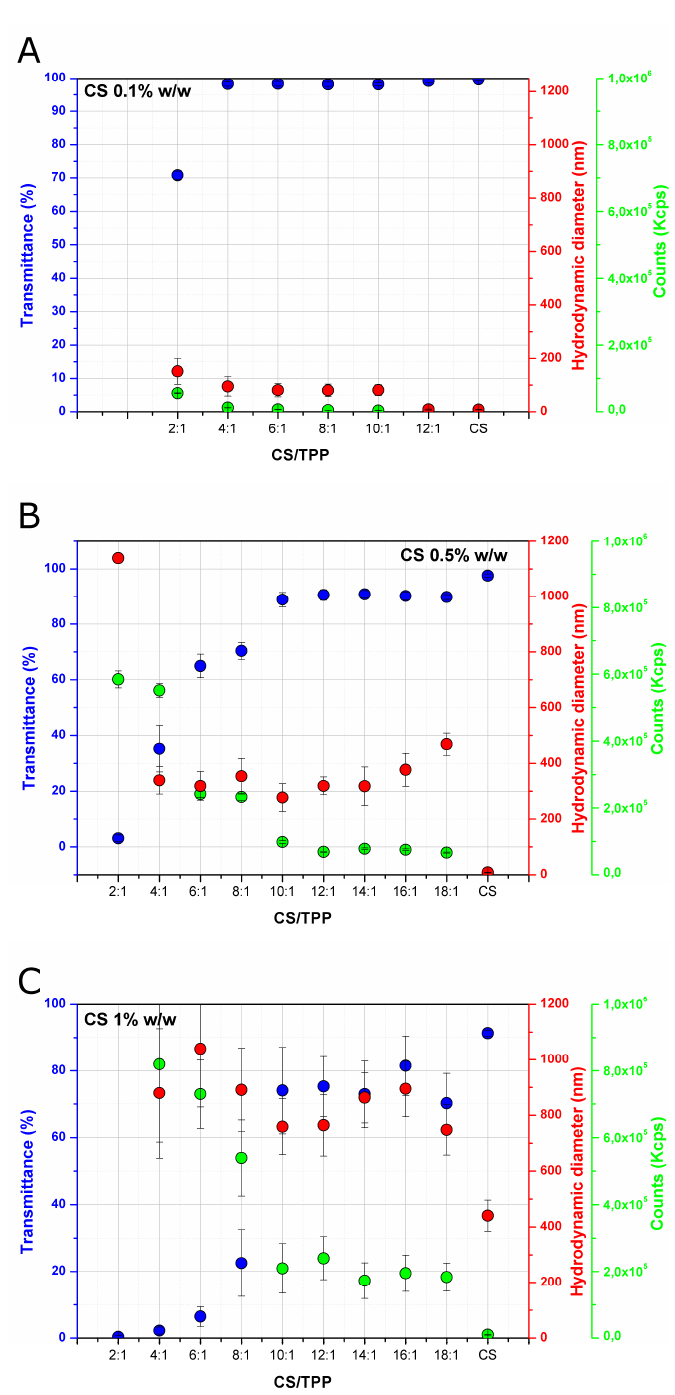
Figure 1. Hydrodynamic diameter (nm), counts (Kcps) and transmittance (%) of nanoparticles at different chitosan (CS) concentrations (0.1% ( A ), 0.5% ( B ) and 1% ( C ); w / w ) and different CS/sodium tripolyphosphate (TPP) ratios prepared in 200 mM acetate buffer pH 4.5. Values are reported as mean ± SD of three independent measurements.